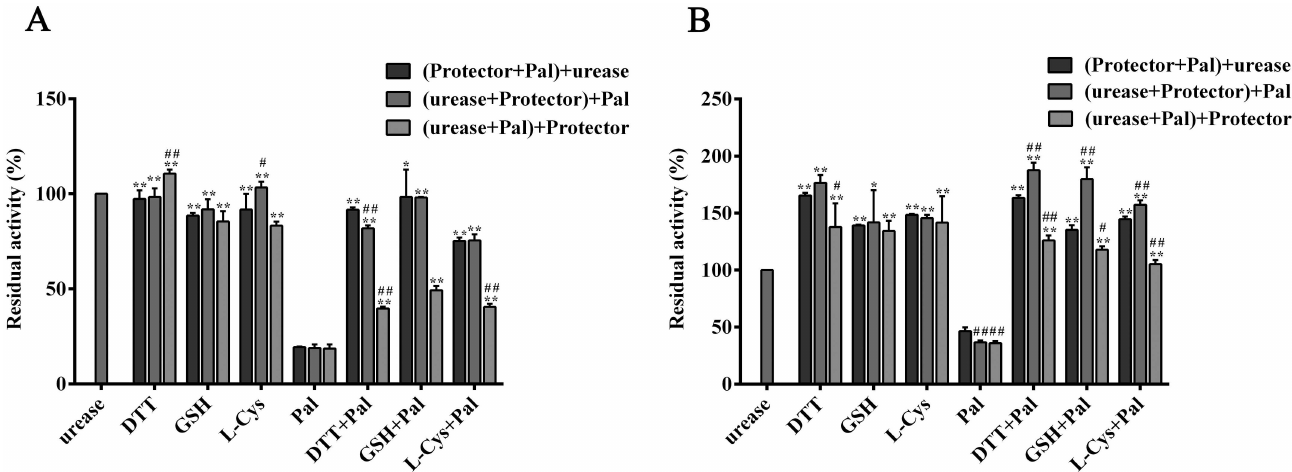
Fig 5. Effect of different component preincubation orders on HPU (A) and JBU (B) inactivated by Pal. The initial 20 min preincubation mixture containedcomponents given in brackets. Further preincubationwas continuedfor another 20 min after the additionof the last component(given outside the brackets). The concentrations of both ureases were 0.25 mg/mL. The concentration of all thiols used was 1.25 mM and Pal was 0.5 mM. Residualactivity values were expressedas percent of the control activity. Results summarizedhere are the mean value of n = 3 ± SD. The residual activity of urease in the presenceof Pal without the thiols is given for comparison. * P < 0.05 and ** P < 0.01 were considered as significantdifferences when comparedwith control value (urease in the presenceof Pal without the protector), and # P < 0.05 and ## P < 0.01 in comparisonto the control (the first column of each group) and, as determinedby one-wayANOVA.